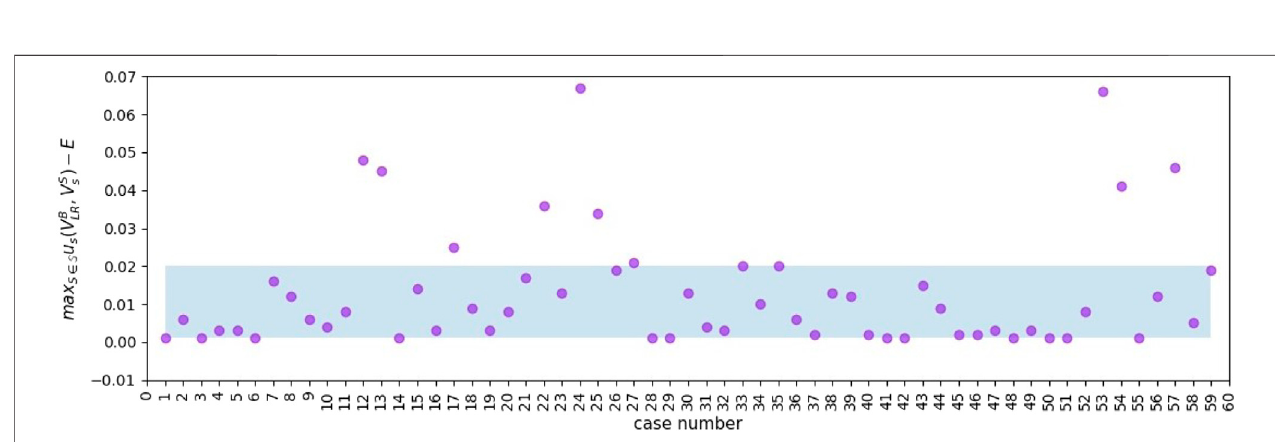
FIGURE 4 | The difference between the maximum utility value and the equilibrium utility value under the branch of the Leader Rank decision tree for the 59 cases where the blocker doesn ’ t choose the Leader Rank strategy.